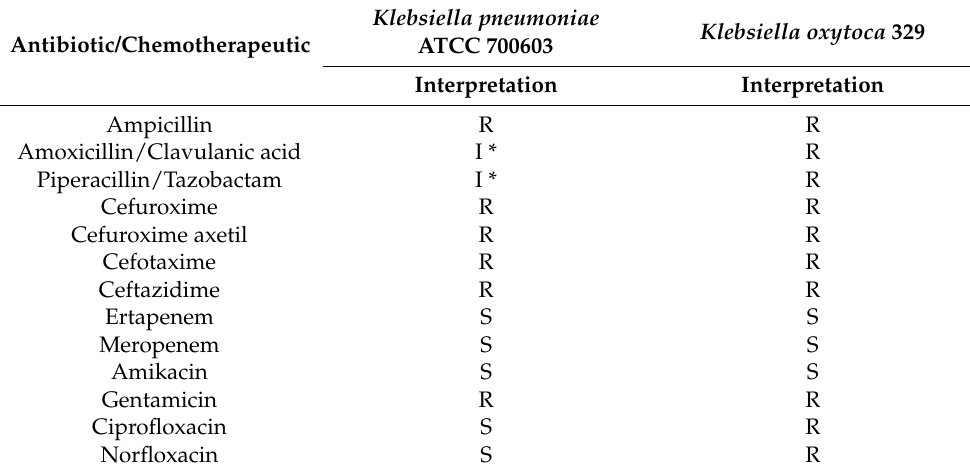
Table 3. Antibiotic susceptibility of Klebsiella pneumoniae ATCC 700603 and Klebsiella oxytoca 329.